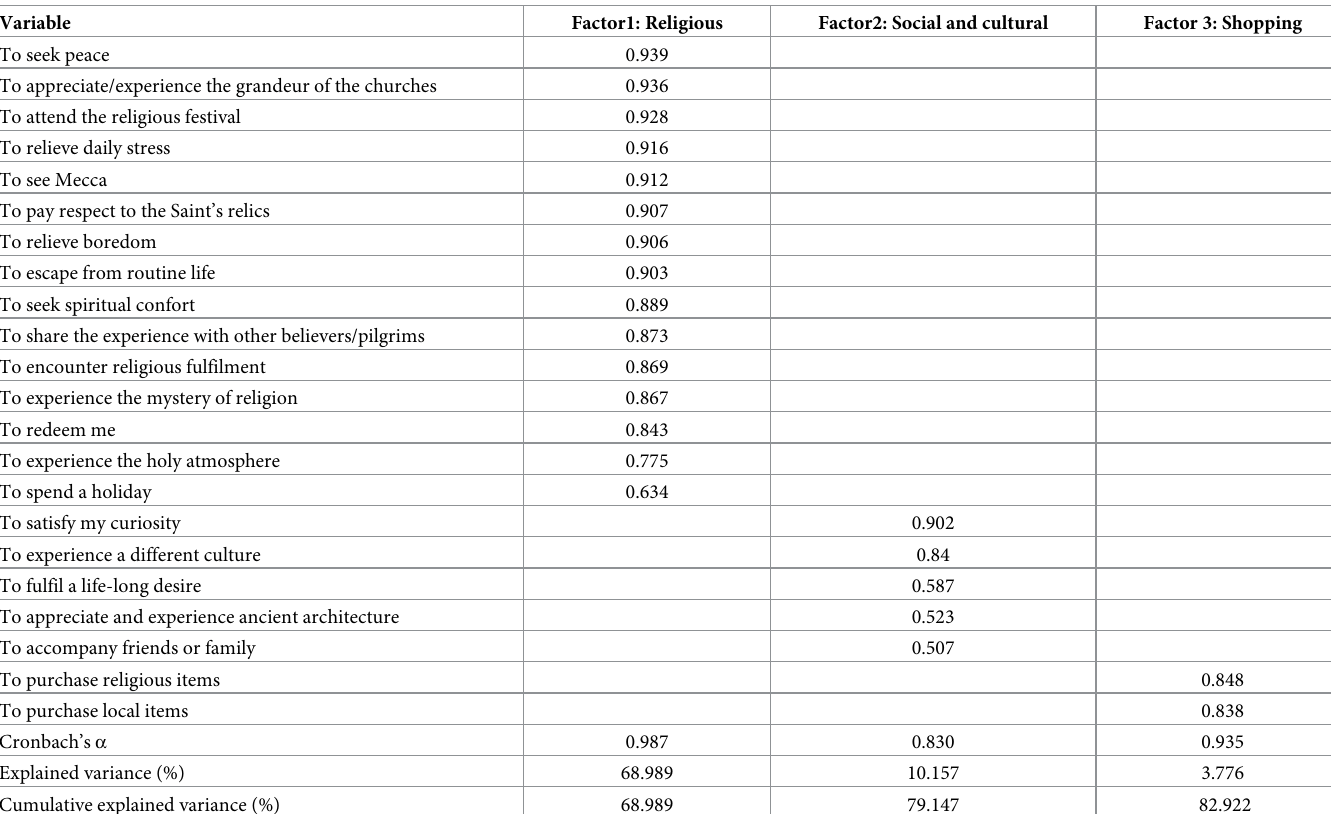
Table 1. Motivations in religious tourism (factor analysis).